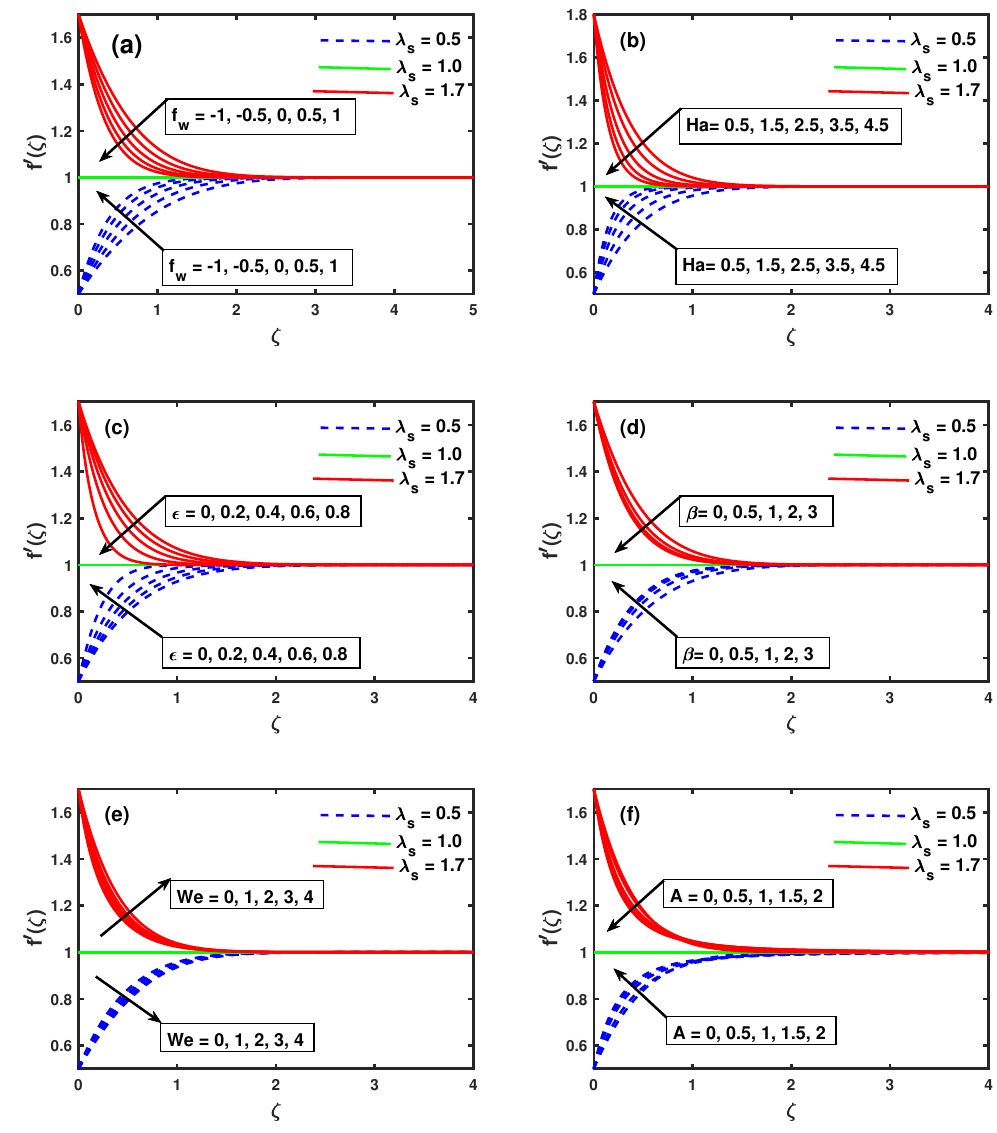
Figure 2. Fluctuation of f (cid:48) ( ζ ) (velocity profile) along with f w (suction/injection) ( a ), Hartmann number ( Ha ) ( b ), (cid:101) (material power law index) ( c ), β (wedge angle) ( d ), Weissenberg number ( We ) ( e ), and unsteadiness parameter ( A ) ( f